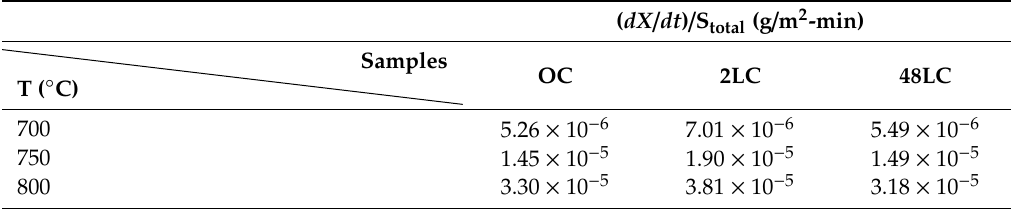
Table 3. Specific area normalized reactivity at 3%